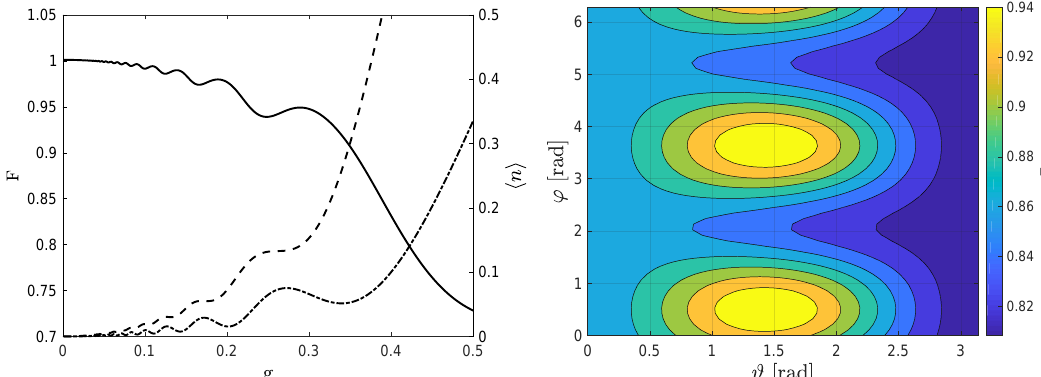
√ √ Figure 1. ( Left ) for the initial state | ψ (cid:105) = 0.2 | g (cid:105) + i 0.8 | e (cid:105) , fidelity F (full curve, left axis) and mean photon number (cid:104) n (cid:105) (right axis, dashed curve) as a function of the qubit-cavity coupling strength g . The mean photon number is also shown for the pure DCE (dot-dashed curve). ( Right ) Contour plot for fidelity F as a function of the Bloch sphere angles θ and ϕ for the input state, at g =